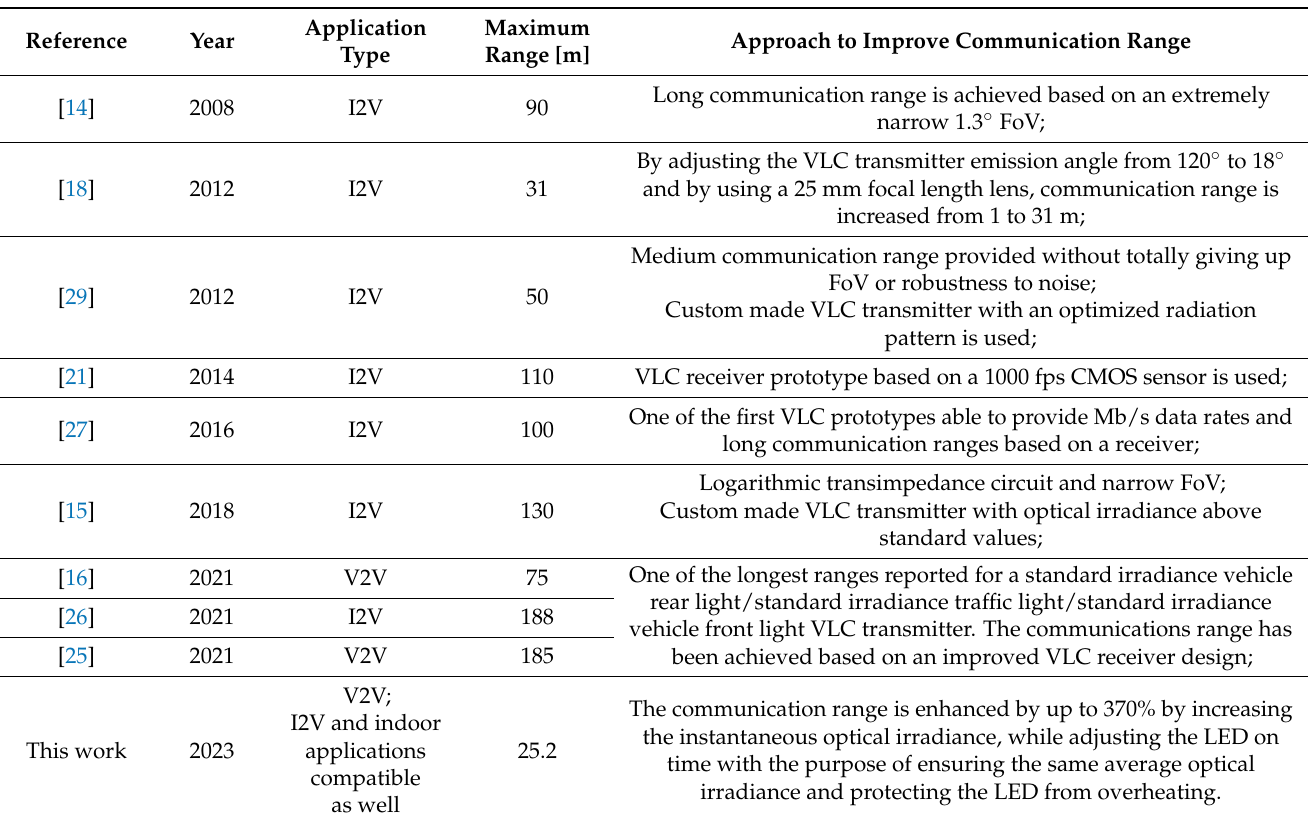
Table 1. Summary of the vehicular VLC communication range